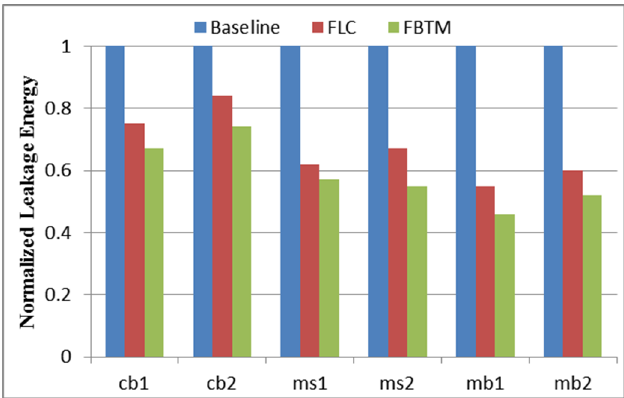
Figure 7. Comparison of leakage energy results.